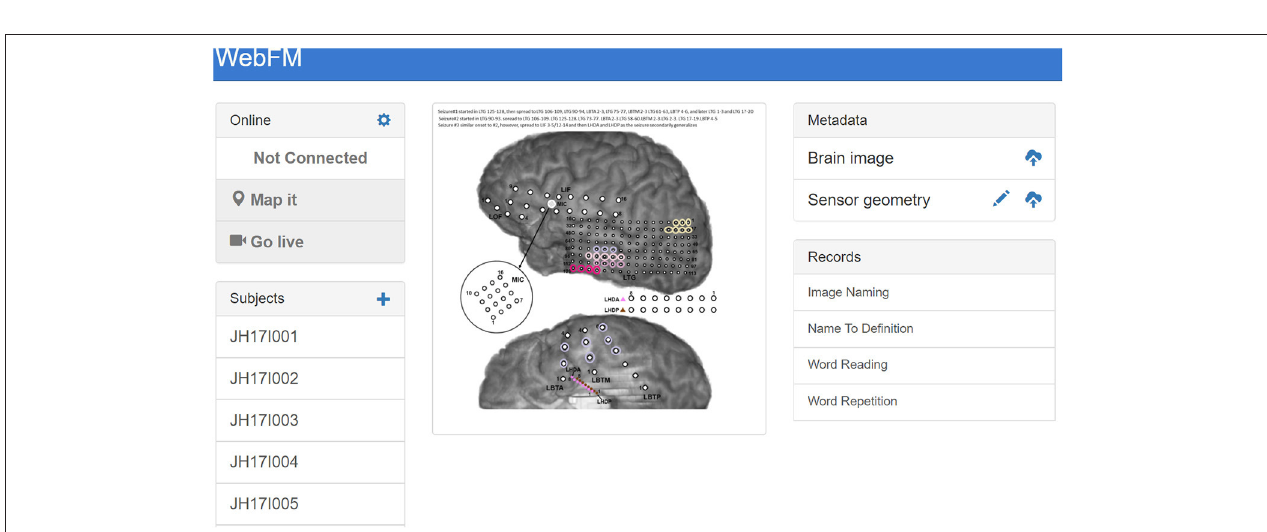
FIGURE 2 | A screenshot of the BCI2000 remote control interface. The paradigm index is hosted by BCI2000Web over HTTP. This page is populated by the experimental paradigms present on the host machine (center) with buttons to start sub-tasks and specific blocks (right). A pane in the top left reads out the current BCI2000 system state, in addition to a system reset button. In the bottom left, a link to the system replay menu allows for recorded BCI2000 .dat file playback for system testing and offline mapping.